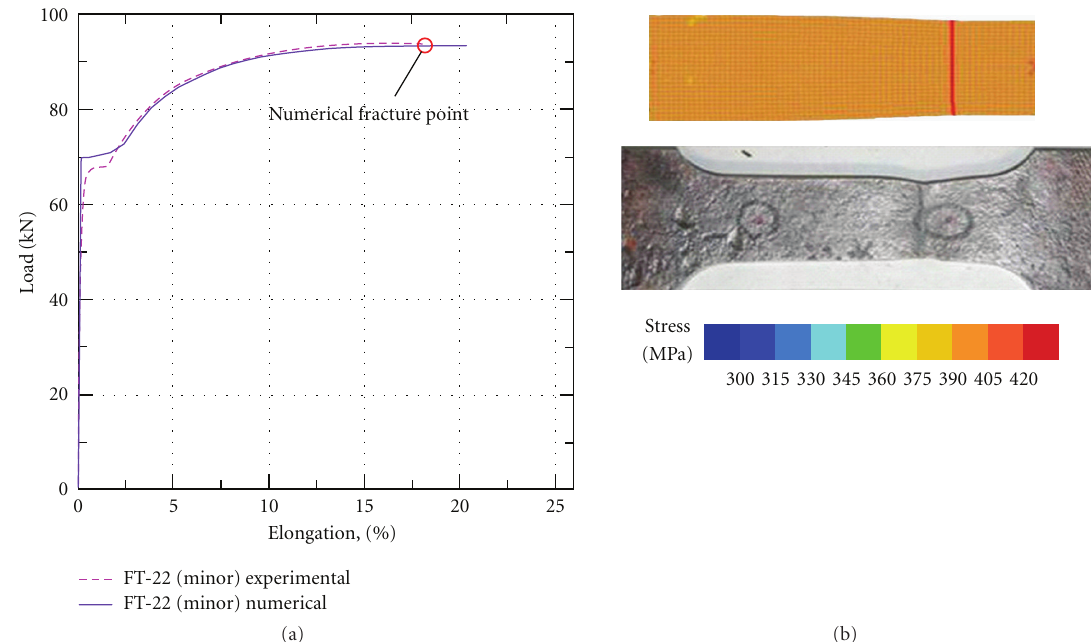
Figure 5: (a) Comparison of experimental and analytical load-elongation curves and (b) stress distribution at ultimate load for the minor corrosion member [FT-22].